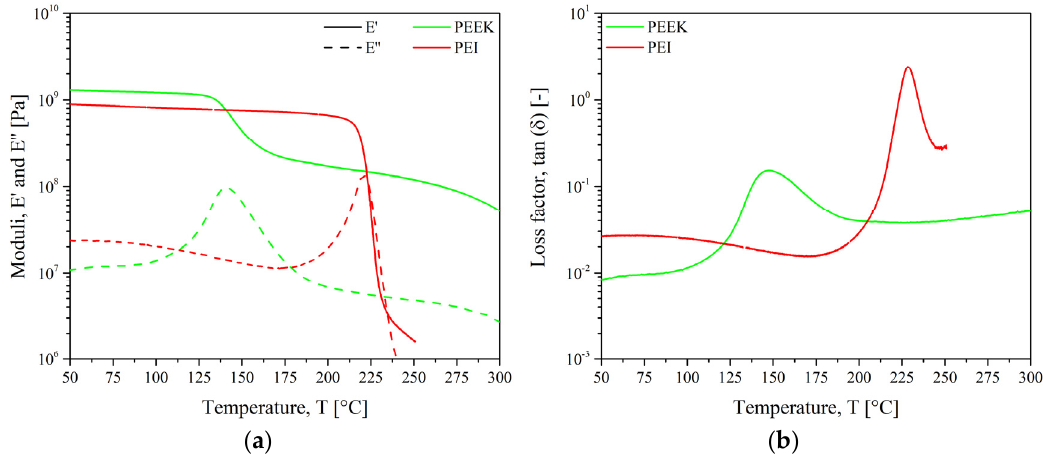
Figure 9. Dynamic mechanical analysis for pure PEEK and PEI ( a ) storage and loss moduli and ( b ) loss factor.